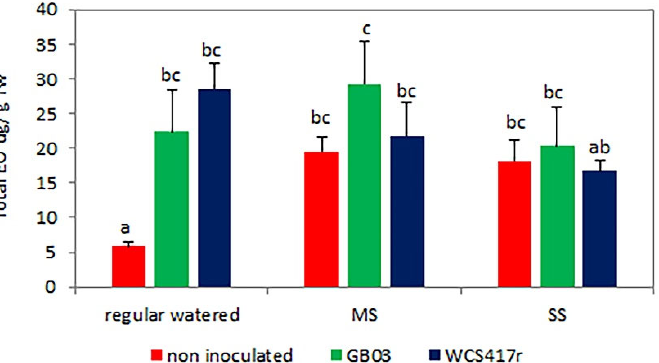
Figure 1. Essential oil yield in M. piperita plants grown under drought stress (MS: moderate stress, SS: severe stress) and inoculated with different Plant Growth Promoting Rhizobacteria (PGPR) strains (mean ± SE). Letters above bars indicate significant differences according to Fisher’s LSD test (n = 15–20, p <0.05). Table 2. Concentrations of major Essential Oil (EO) components ( µ g/g fresh weight) in Mentha piperita plants grown under drought stress (MS: moderate stress, SS: severe stress) and inoculated with different plant growth promoting rizobacteria (PGPR) strains (mean ± SE). Means followed by the same letter in a given column are not significantly different according to Fisher’s LSD test (n = 15–20, p <